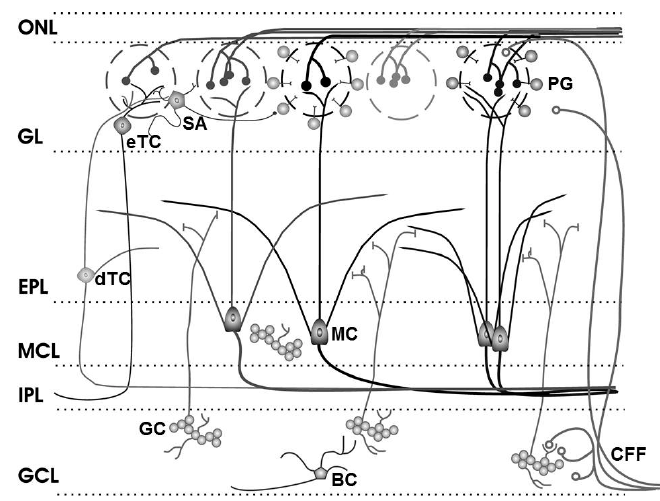
Figure 2. Olfactory bulb circuitry. Olfactory receptor neuron axons enter the main olfactory bulb through the olfactory nerve laver (ONL), to synapse with periglomerular cells (PG), mitral cells (MC) and tufted cells (of which external, eTC, and deep, dTC, tufted cells are shown) within the glomerular layer (GL). Short Axon (SA) cell axons receive synaptic input from eTCs and form extensive interconnections between glomeruli, while mitral cell apical dendrites convey sensory information to deeper layers of the bulb. In the external plexiform layer (EPL), mitral and (deep) tufted cells extend lateral dendrites which release glutamate onto the dendrites of granule cells (GC). Mitral cell bodies are located in the mitral cell layer (MCL), which is also densely packed with granule cells. Mitral and tufted cell axons project through the internal plexiform layer (IPL) to olfactory cortex (their axon collaterals branching into the GCL are not shown). The granule cell layer (GCL) contains the major population of inhibitory granule cells. Blane’s cells (BC) within the GCL make inhibitory contact with granule cells. Centrifugal fibers (CFF) shown projecting to the GL and GCL include glutamate-releasing axons of olfactory cortex pyramidal cells receiving mitral cell output. Modified from [60]; original drawing by Cristina